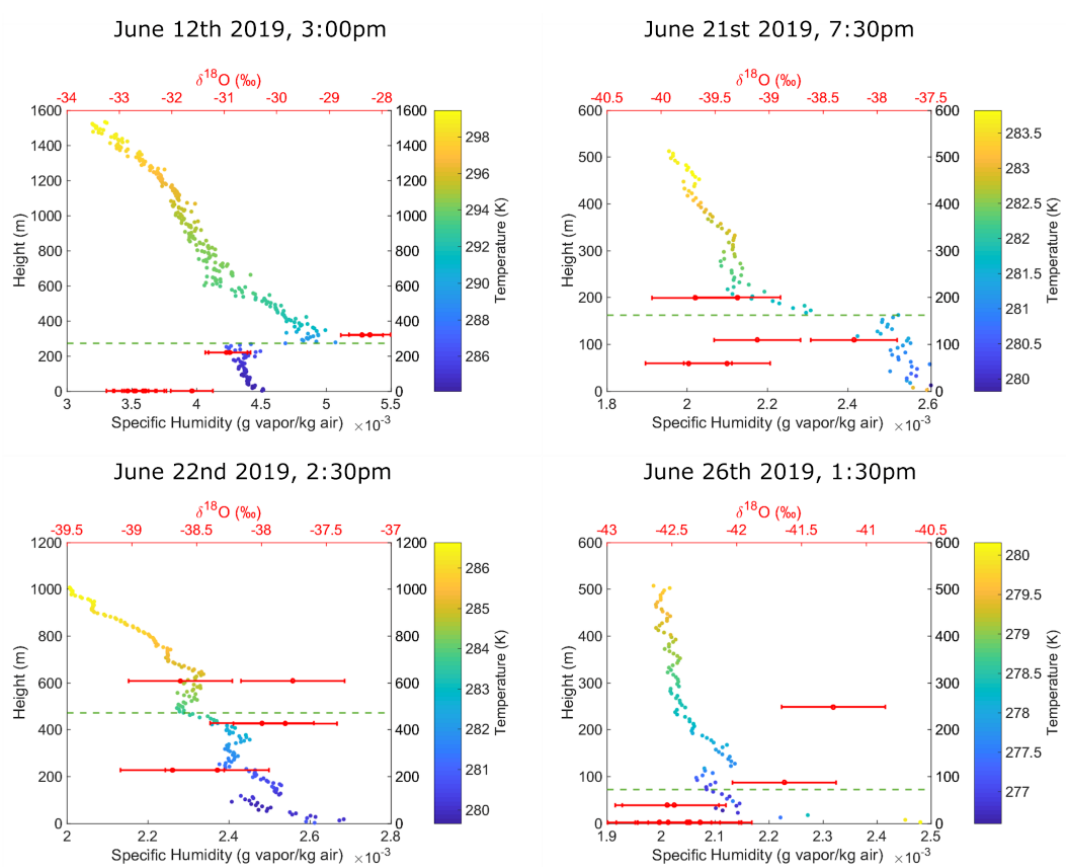
Figure A5. The four flights during the 2019 summer field session at the EastGRIP field camp. Includes collected environmental data during flight for both ascent and descent as well as measured isotope values for